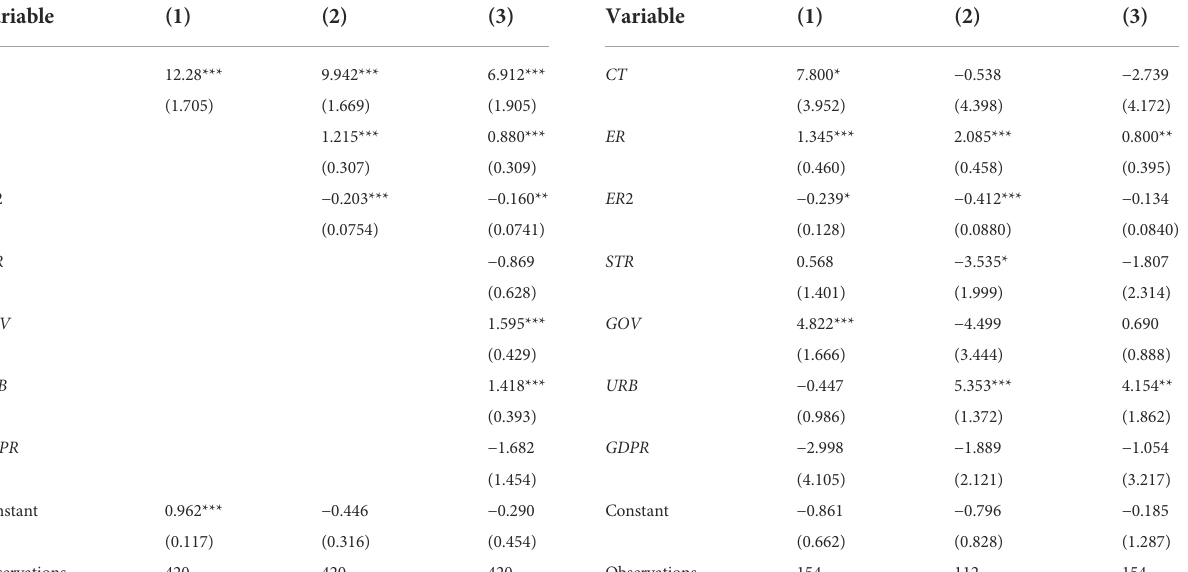
TABLE 2 The effects of clean technology innovation on industrial green total factor productivity. Variable